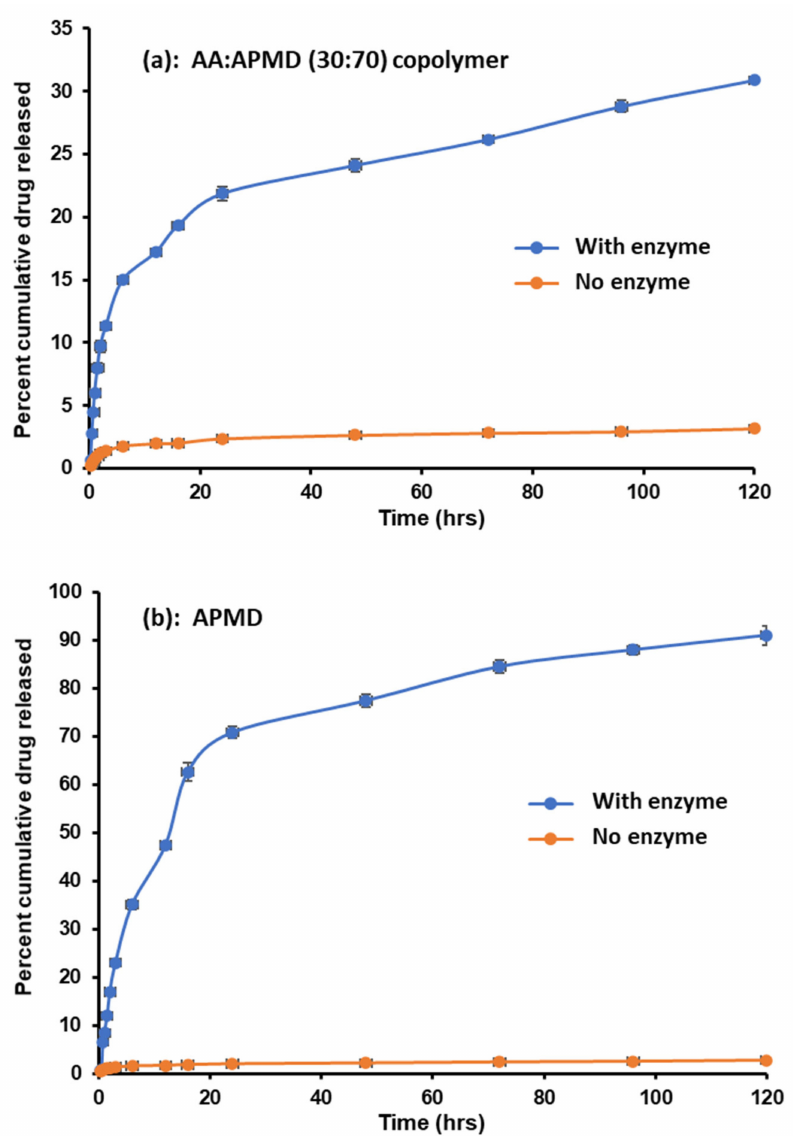
Figure 4. Release of PMD from ( a ) the AA/APMD (30:70) copolymer, with or without porcine liver esterases, and ( b ) from the monomer–repellent conjugate (APMD). Data are mean ± SD ( n =